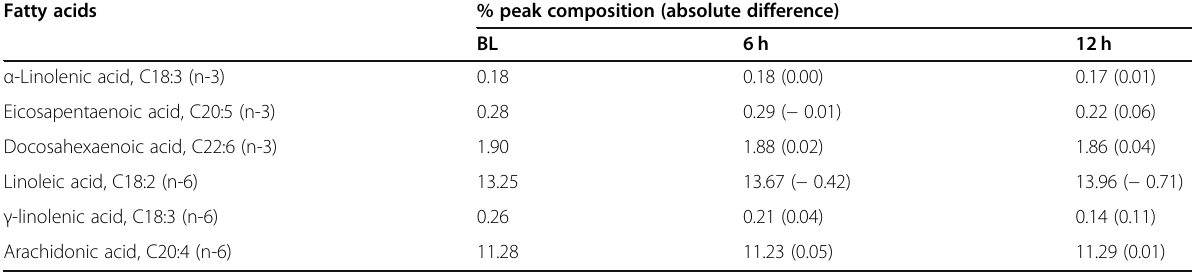
Table. 7 Stability of fatty acids due to delay in processing Fatty acids